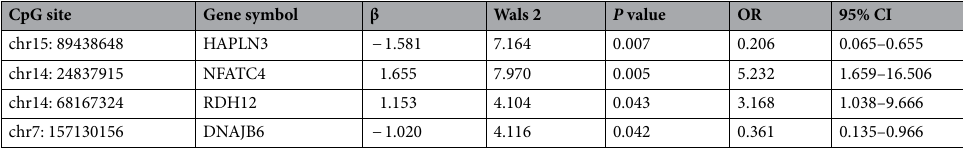
Table 5. Conditional logistic analysis of methylation status of CpG sites on GDM. OR odds ratio, β regression coefficients, 95% CI 95% confidence interval of